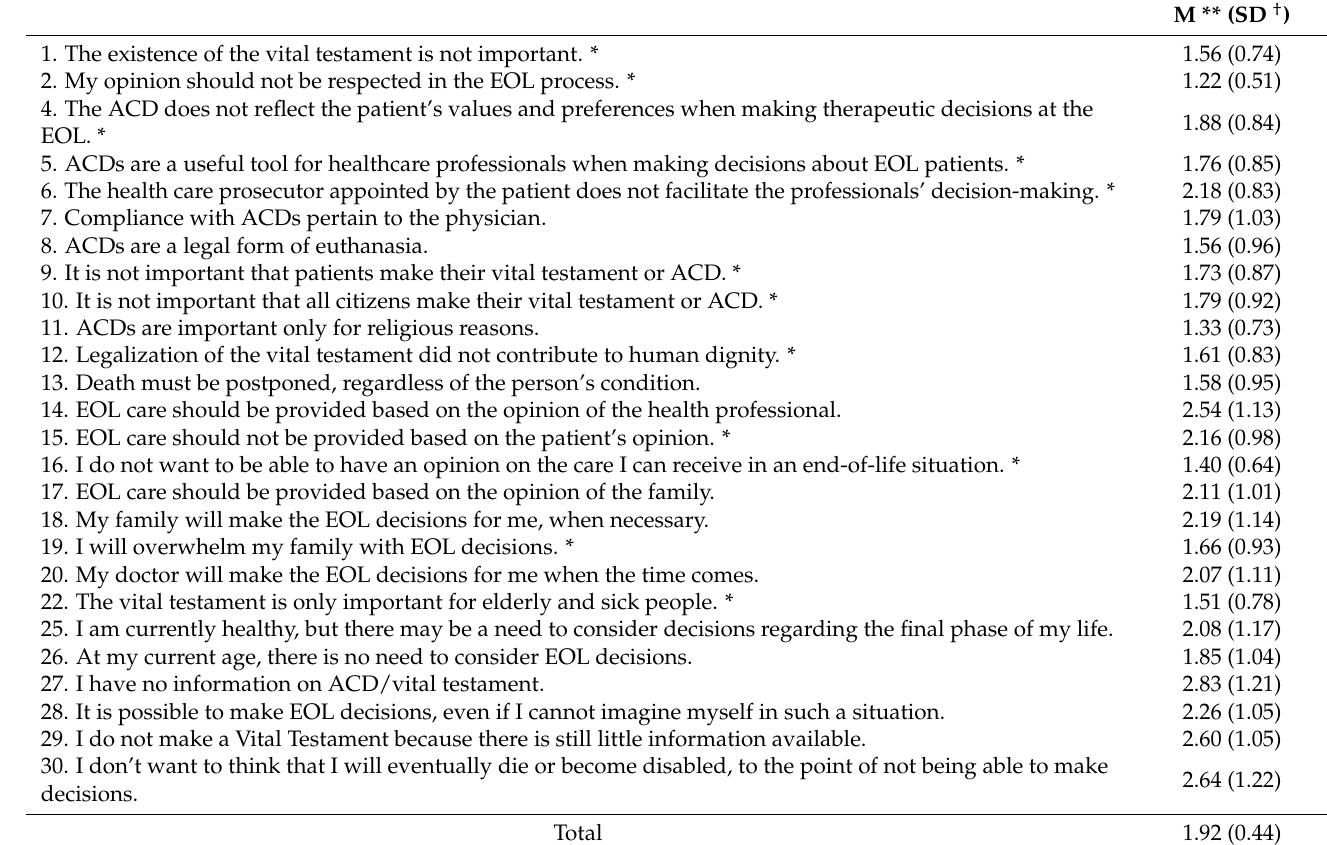
Table 3. Descriptive statistics of the General Public Attitudes toward Advance Care Directives (GPATACD)